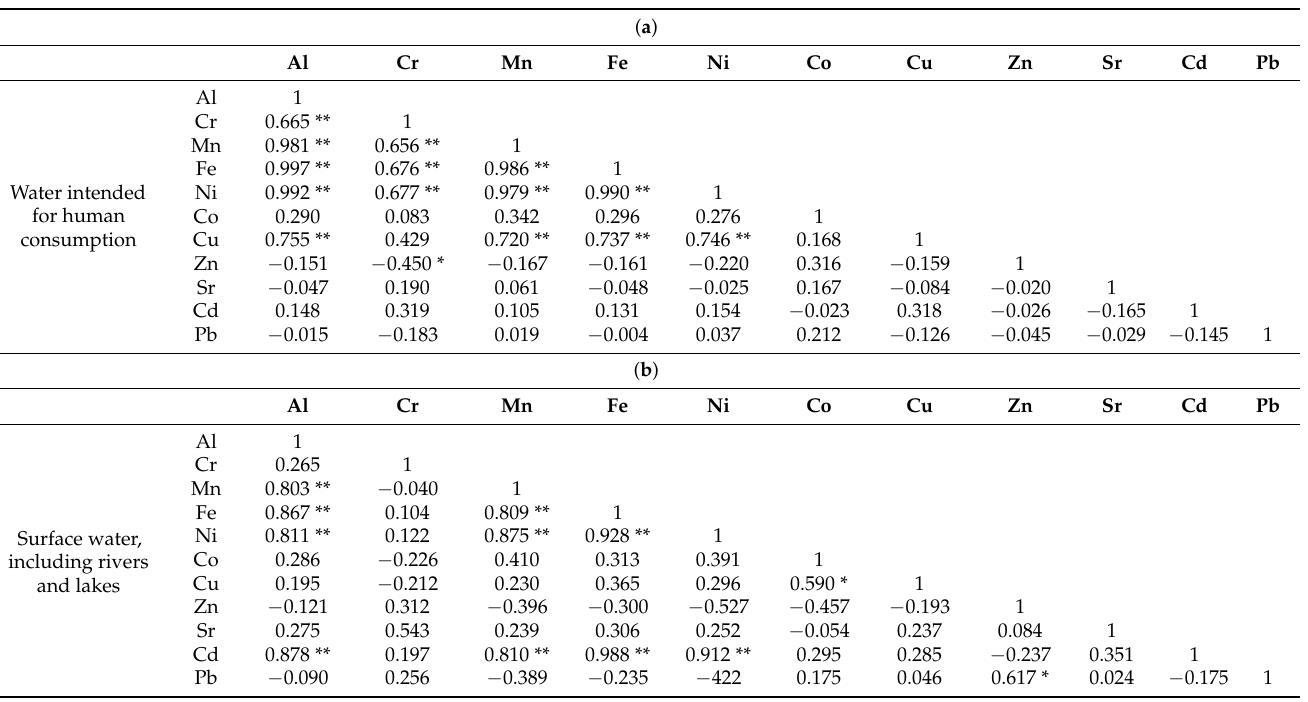
Table 10. ( a ) Pearson’s correlation matrix for toxic metal concentrations (drinking water); ( b ) Pearson’s correlation matrix for toxic metal concentrations (surface